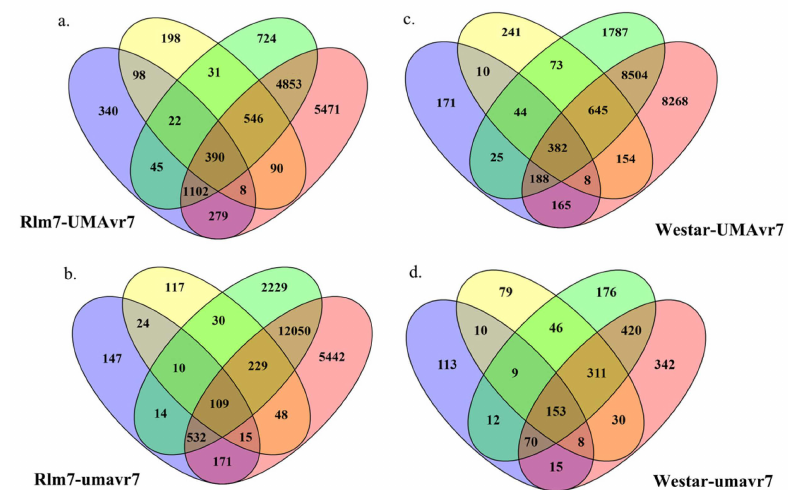
Figure 4. Differentially expressed genes (DEGs) in two canola genotypes and two L. maculans isolates under four different host-pathogen interactions. Number of DEGs in two hosts, 01-23-2-1 (Rlm7 line) and Westar (no R genes), and in two L. maculans isolates UMAvr7 (with AvrLm7 ) and umavr7 (mutant of AvrLm7 ) under each host-pathogen interaction at 1-, 3-, 7-, and 11-days post inoculation compared to 0-dpi analyzed by dual RNA-seq are shown. Results were representative of three biological replicates. The results were considered at the fold-change cutoff (logFC) of ≥ 1 and ≤− 1 and false discovery rate (FDR) of ≤ 0.05.